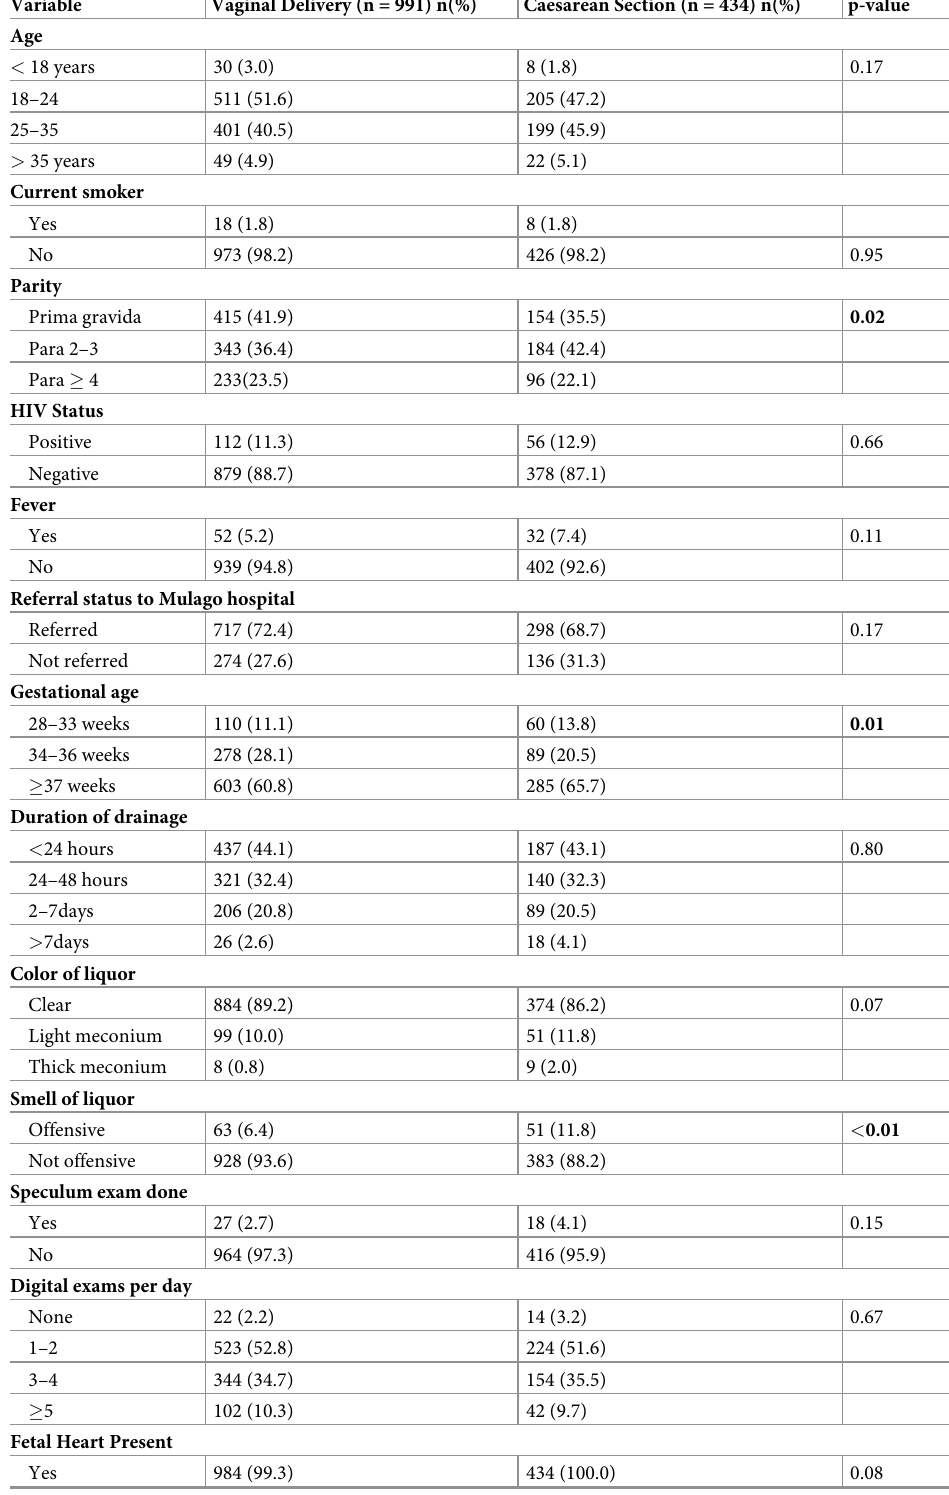
Table 1. Baseline characteristics of 1425 participants with PROM at Mulago Hospital,